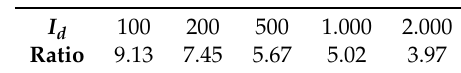
Table 14. (cid:107)G(cid:107)